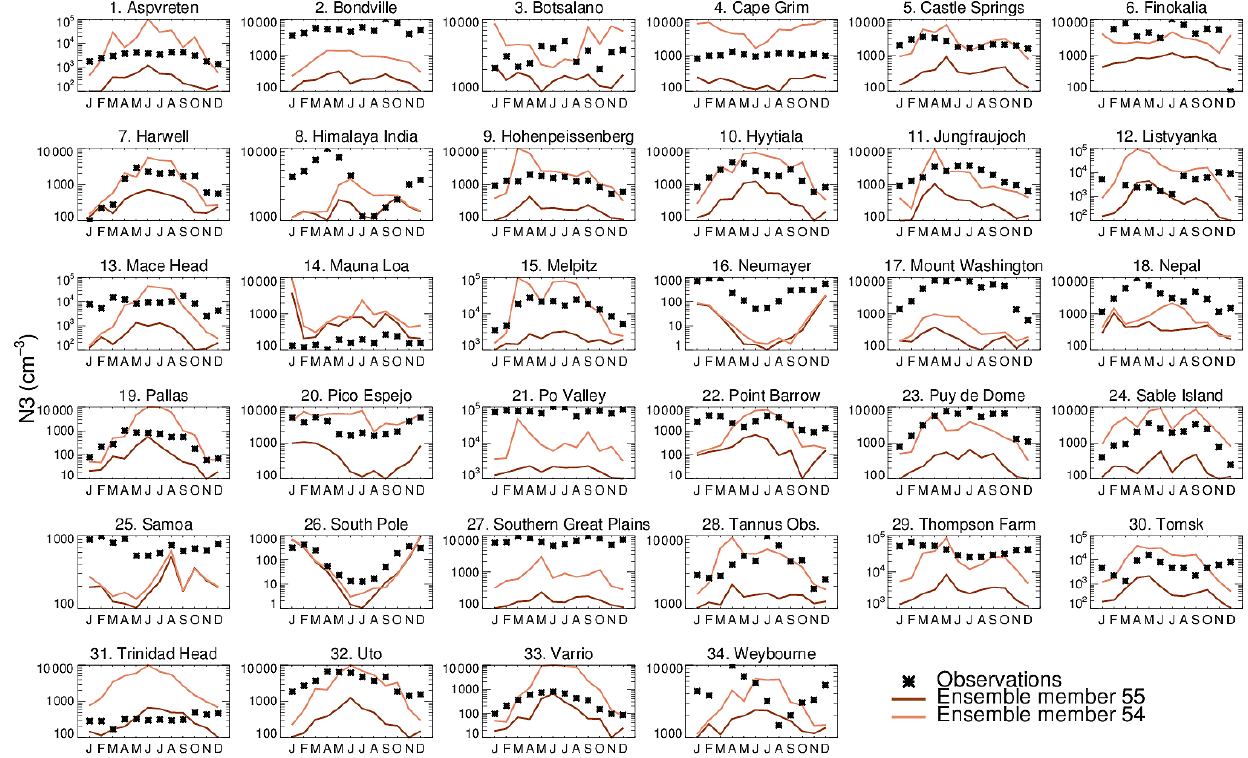
Figure A1. Annual cycle of simulated (solid lines) and observed (black stars) monthly mean surface-level N3 concentrations at 34 ground- based sites. The ensemble members shown are those with the lowest and highest number concentrations of global mean surface-level N3 from Fig.